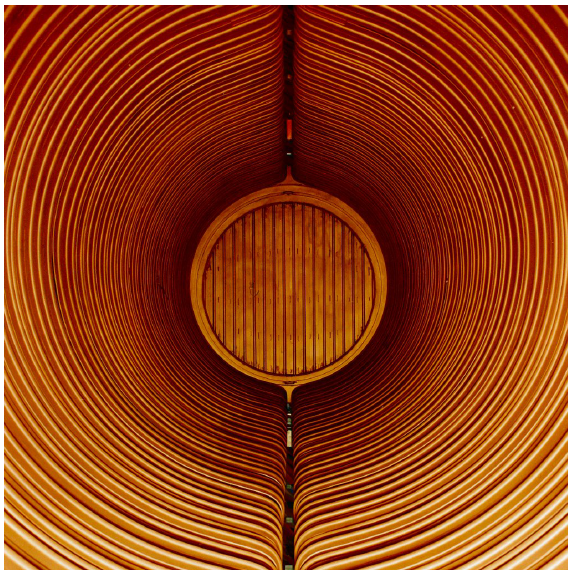
Figure 1: View into the test